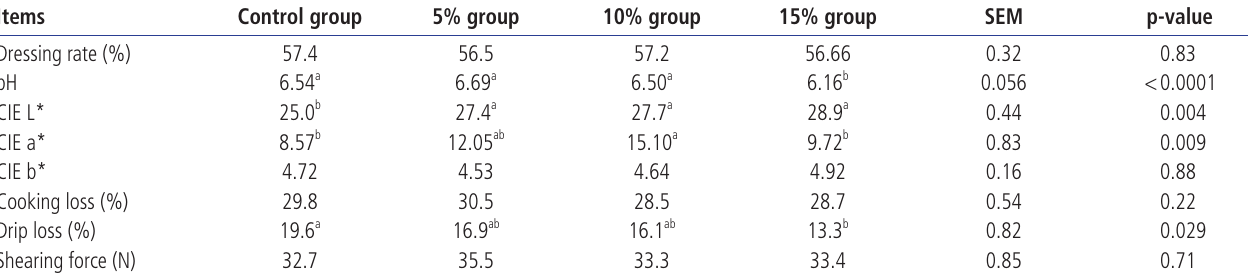
Table 5. Effect of Broussonetia papyrifera silage levels on beef quality of black Angus Items